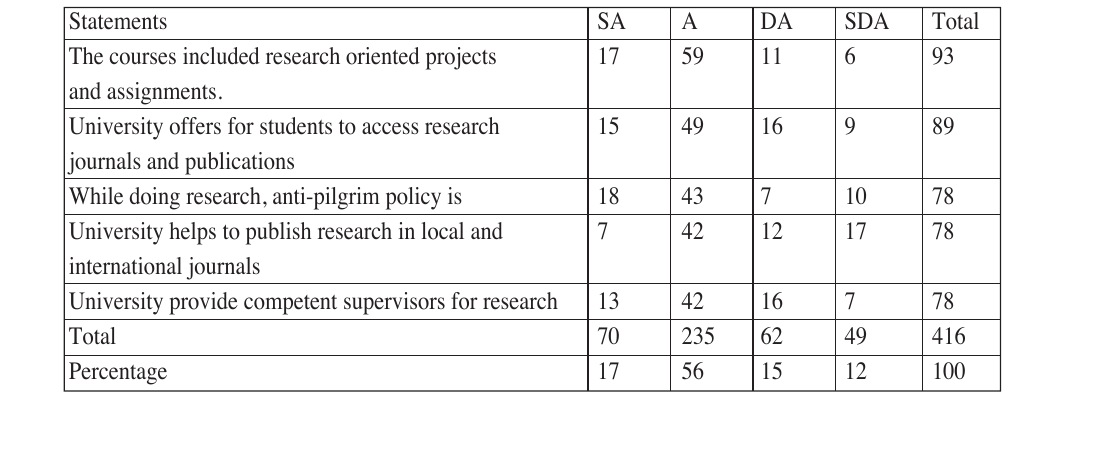
Table No. 6: Research Contribution To maintain the Quality in Higher